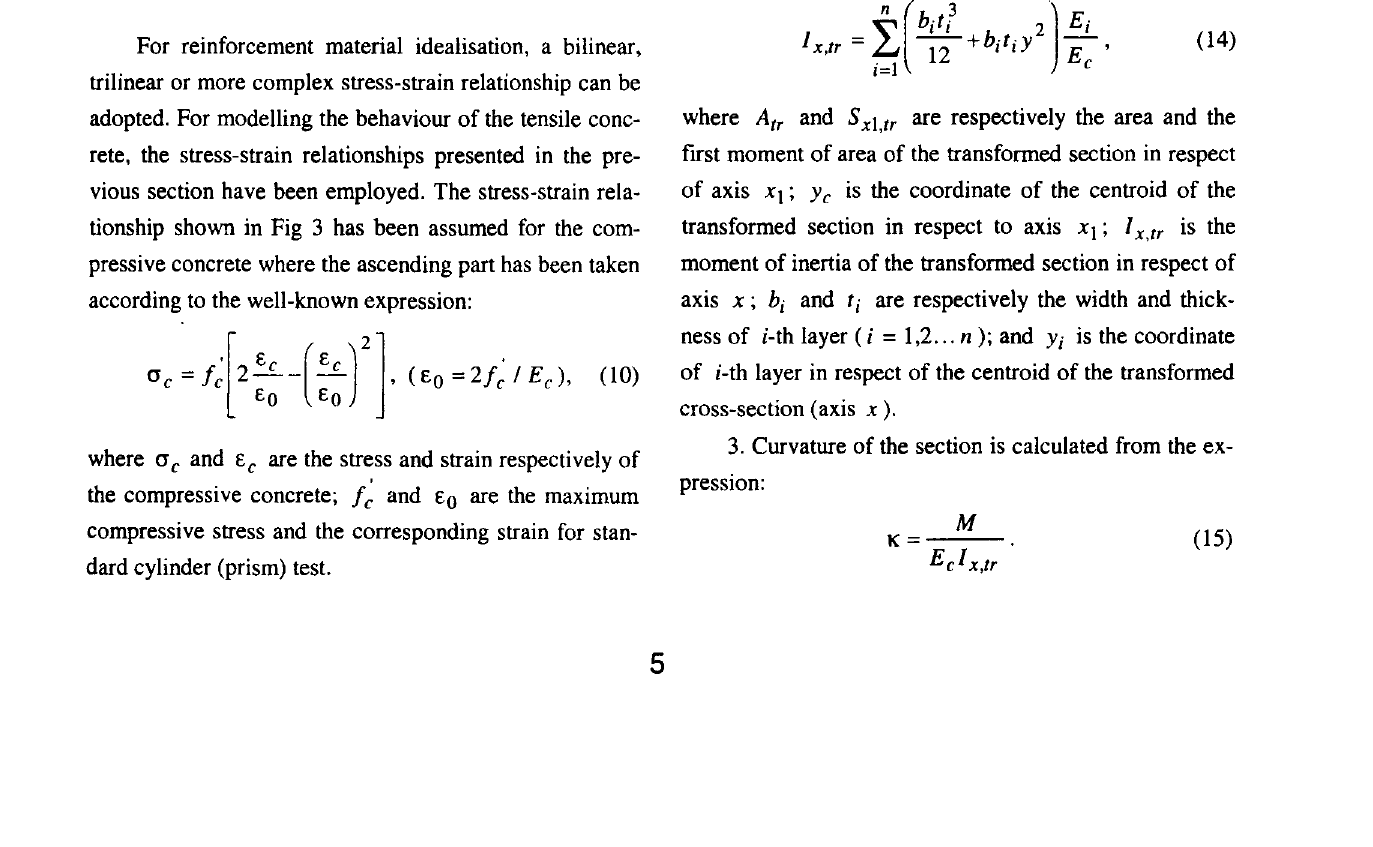
Fig 2. A cross-section of doubly reinforced concrete member in layered approach